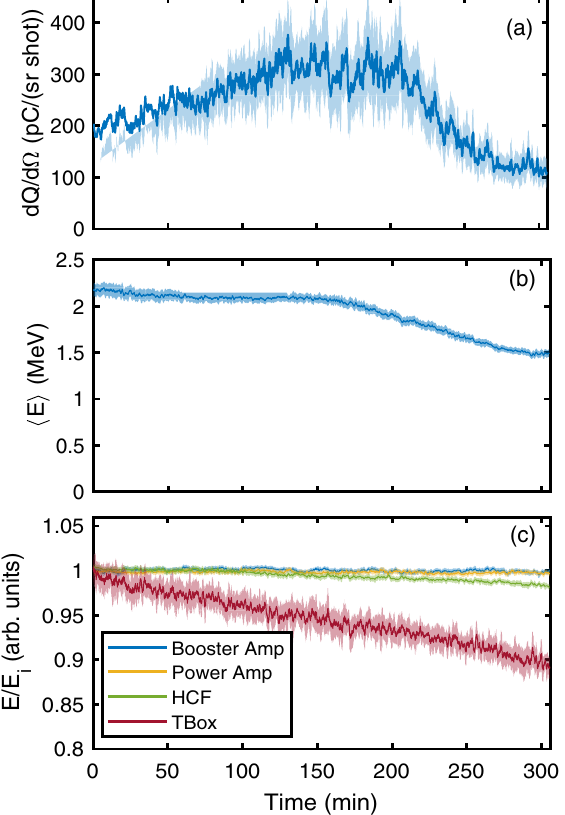
FIG. 4. (a) Total charge per solid angle collected through the electron spectrometer pinhole. (b) Mean electron beam energy versus time. (c) Monitoring of the laser energy at four points in the laser chain. Each curve in this figure is averaged over a one minute moving window and shaded areas represent the corre- sponding standard deviation.